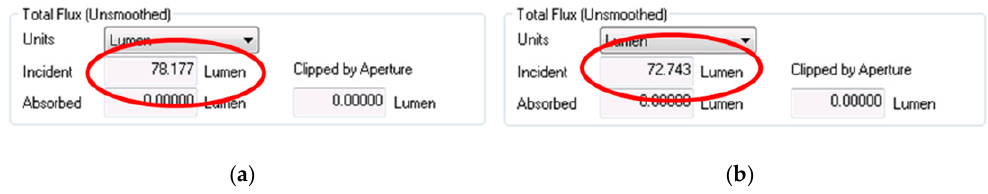
Figure 5. LightTools Light Extraction Efficiency results. ( a ) results for Silver; ( b ) results for Aluminum.